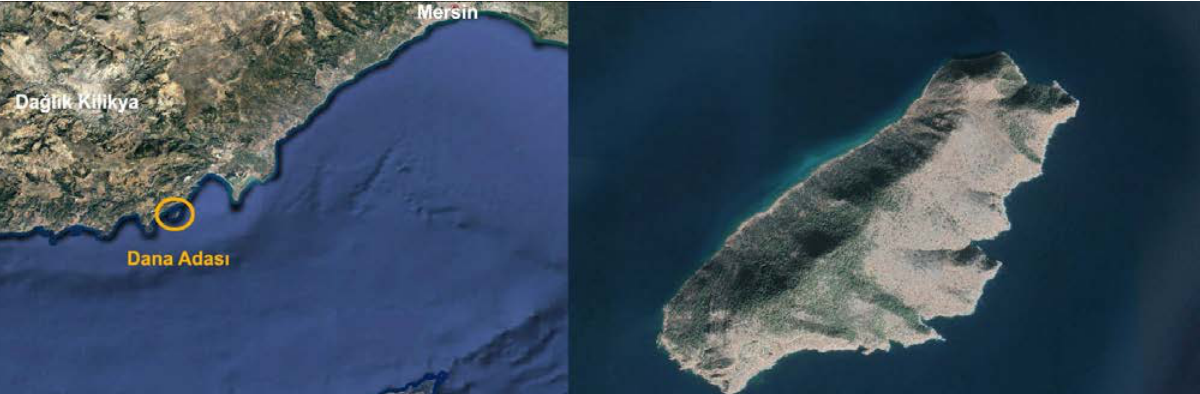
Figure 1. Dana Island is in the east of the Rough Cilicia region on the Mediterranean coast of